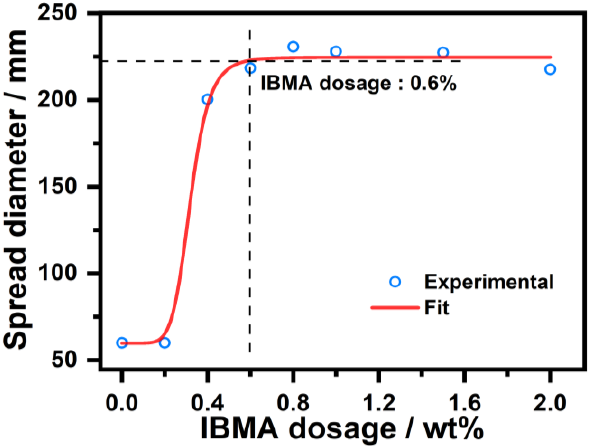
Figure 5. Spread diameter of fresh NHL pastes with varying IBMA content.